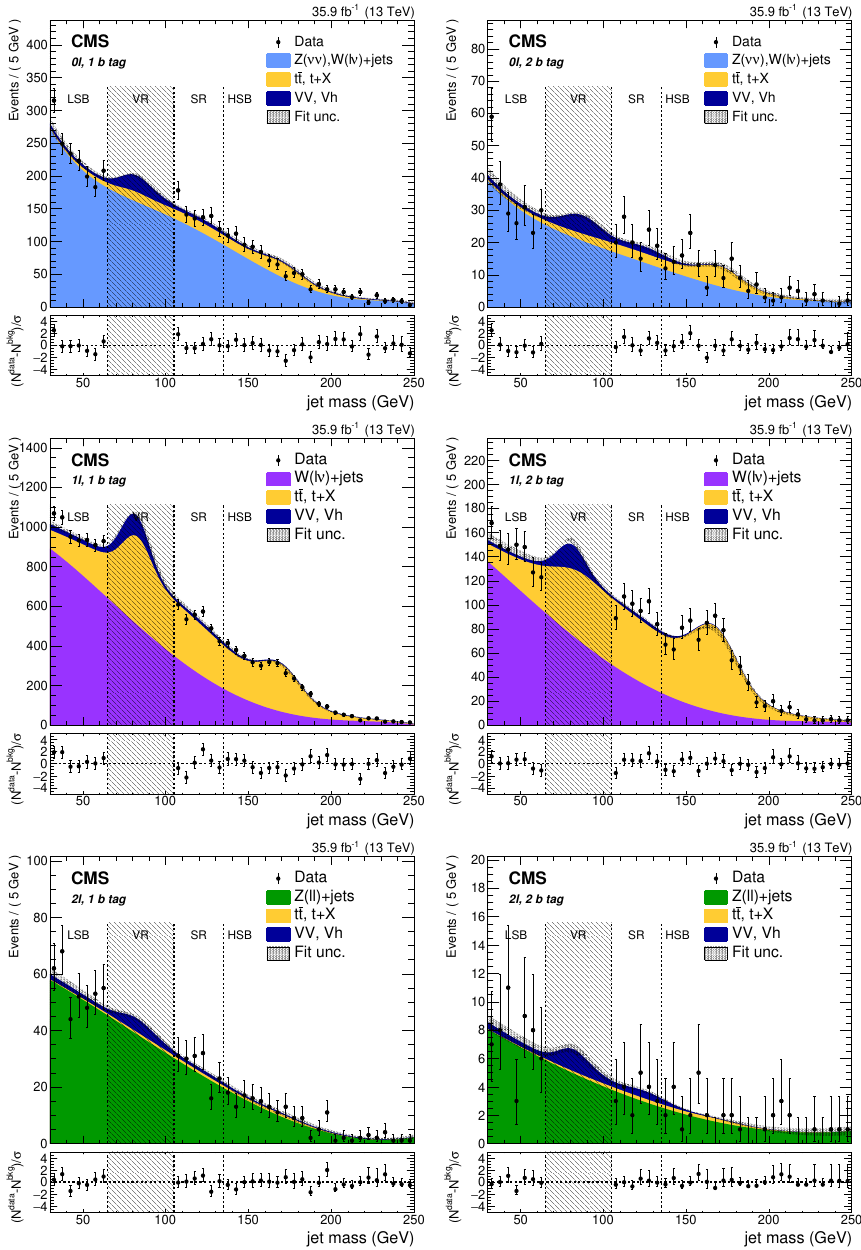
Figure 3 . Soft-drop jet mass distribution of the leading AK8 jet in the 0 ‘ (upper), 1 ‘ (middle), and 2 ‘ (lower) categories, and separately for the 1 (left) and 2 (right) b-tagged subjet selections. The electron and muon categories are merged together. The shaded band represents the uncertainty from the (cid:12)t to data in the jet mass sidebands. The observed data are indicated by black markers. The dashed vertical lines separate the lower (LSB) and upper (HSB) sidebands, the signal region (SR), and the W and Z bosons mass region (VR); the latter is not used in the (cid:12)t to avoid biases from X VV signals. The bottom panels depict the pulls in each bin, ( N data ! is the statistical uncertainty in data, as given by the Garwood interval [72].